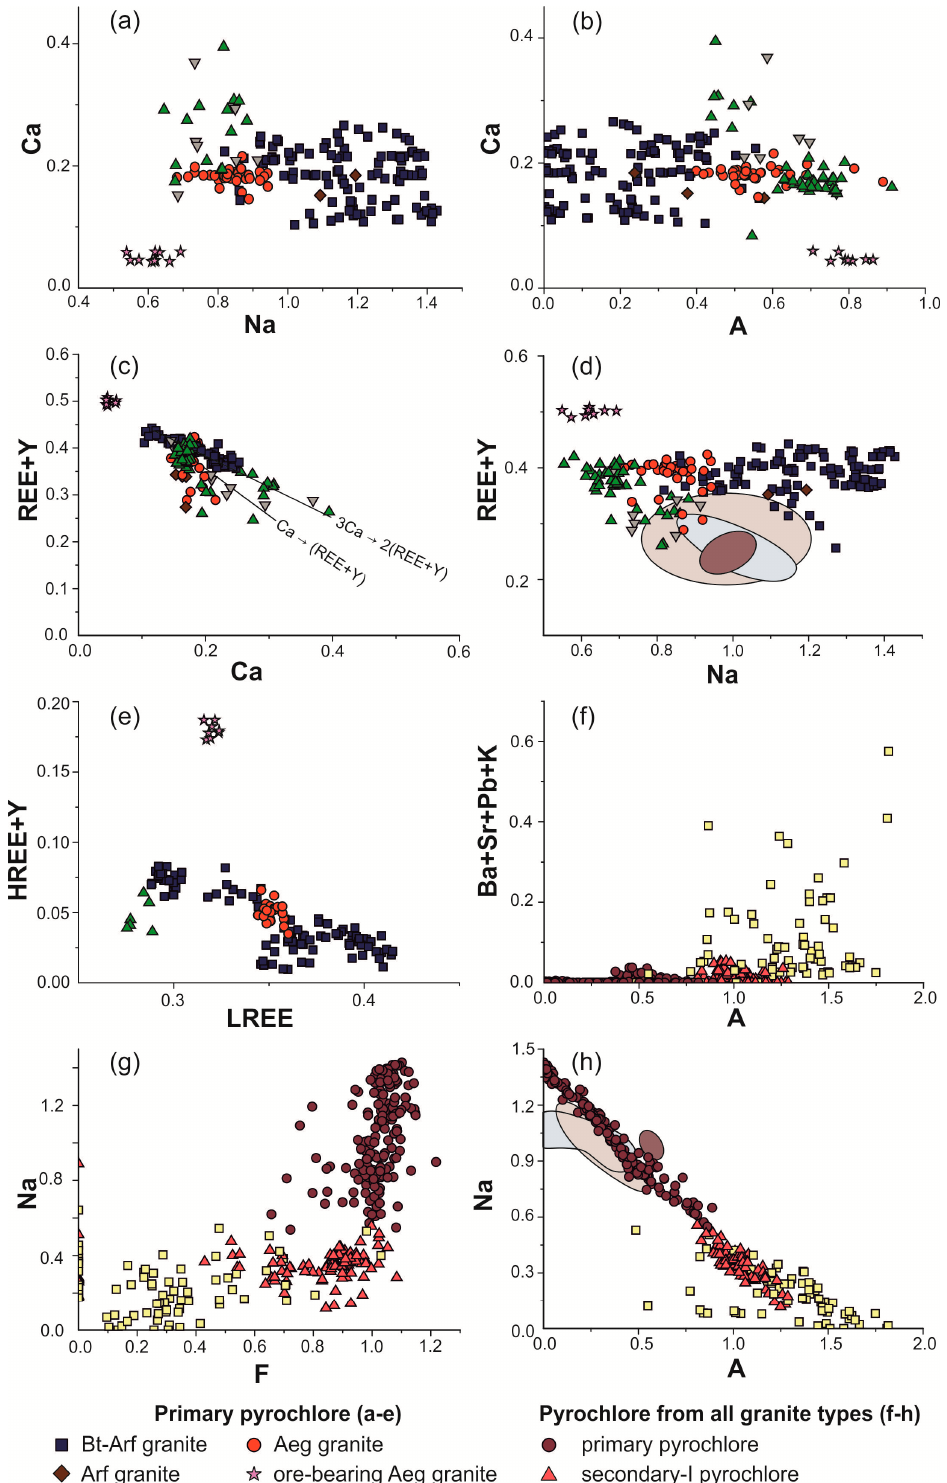
Figure 5. Binary diagrams (apfu) for pyrochlore-group minerals from the Katugin granites. A = vacancy or H 2 O at the A-site. The HREE+Y/LREE diagram includes only WDS data.